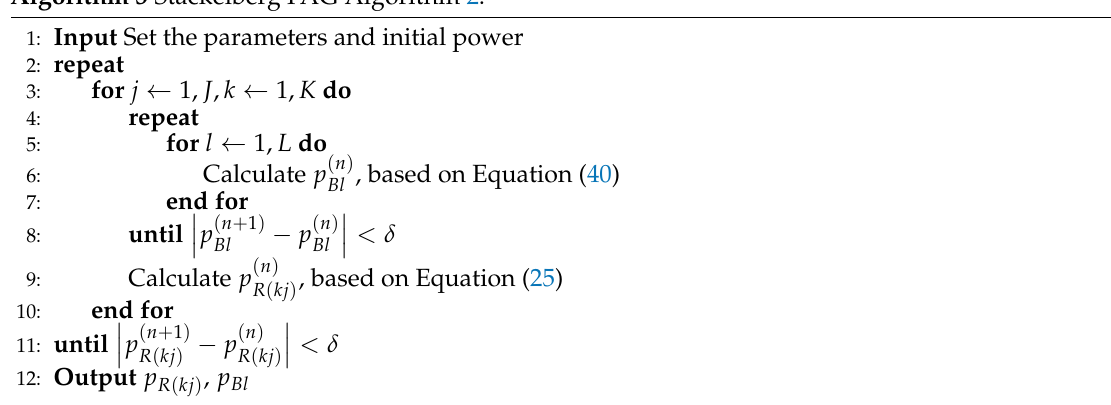
Algorithm 3 Stackelberg PAG Algorithm